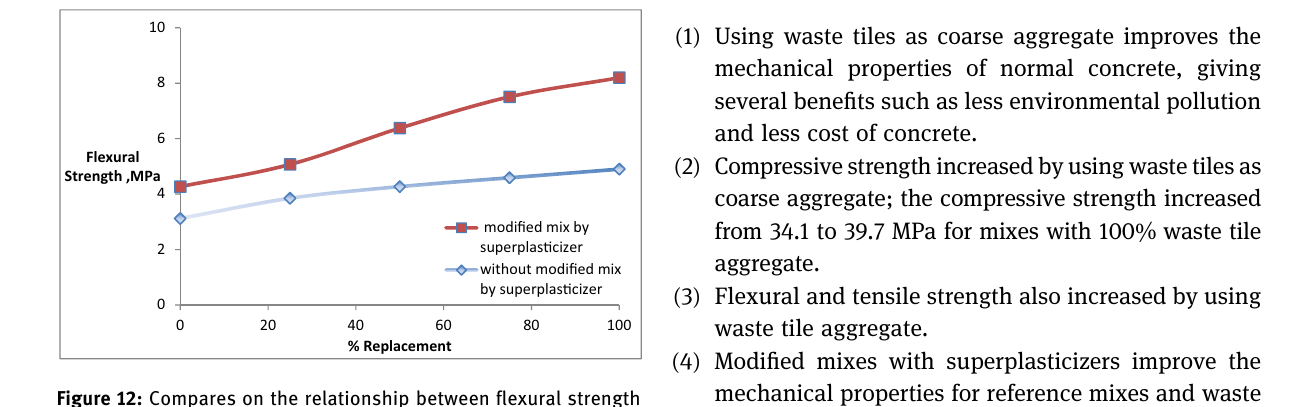
Figure 12: Compares on the relationship between fl exural strength and replacement with and without modi fi cation by superplasticizer.